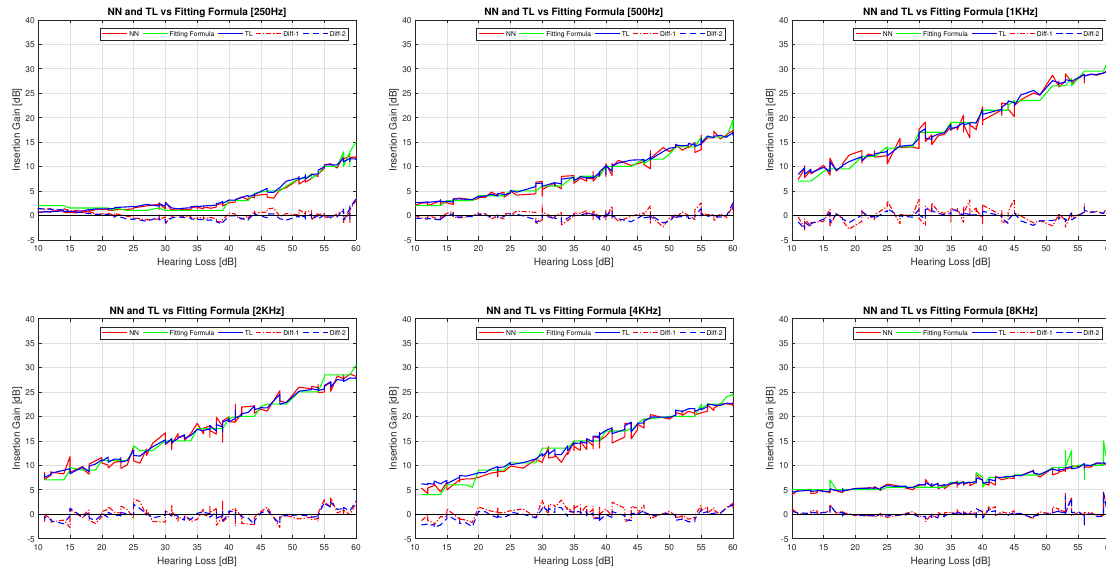
Figure 8. NAL-NL1: Performance comparison for NN and TL vs. fitting formula for the 65 dB input level. Comparisons are made for 250 Hz, 500 Hz, 1 KHz, 2 KHz, 4 KHz, and 8 KHz frequencies from top left to right to bottom left to right.